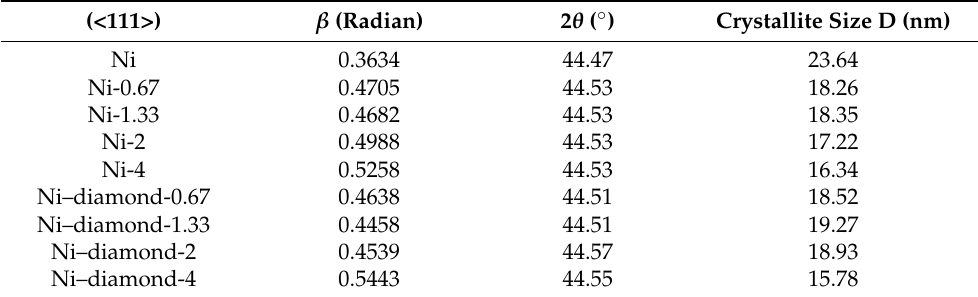
Table 1. The comparison of grain sizes of the Ni coating and the Ni–diamond coating at different current densities (0.67 A/dm 2 , 1.33 A/dm 2 , 2 A/dm 2 , 4 A/dm 2 ).